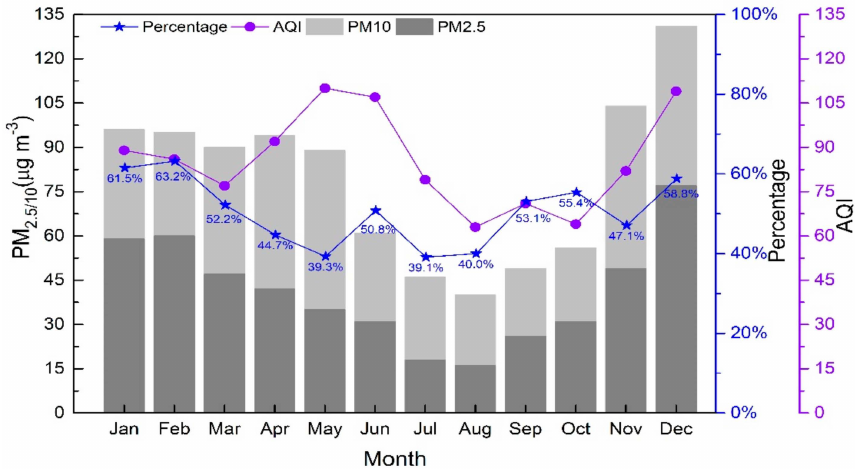
Figure 2. Variation of monthly averaged AQI (air quality index), concentrations of particulate matter (PM) 2.5 / 10 , and the ratio between PM 2.5 and PM 10 (in %) during 2017. The data shown are an average over the data collected at the nine national control monitoring stations in the city of Nanjing shown in Figure